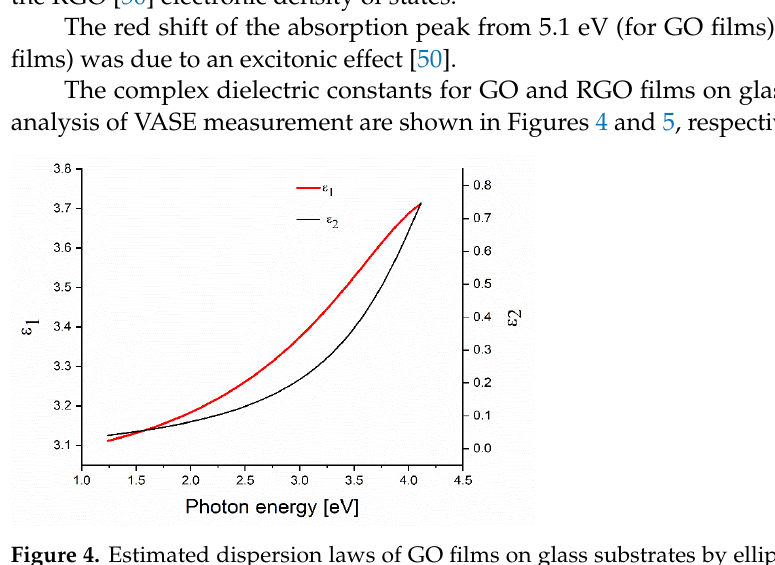
Figure 5. Estimated dispersion laws of RGO films on glass substrates by ellipsometry characteriza- tion. The solid curves represent the real (red curve) and the imaginary (black curve) part of the dielectric constant.